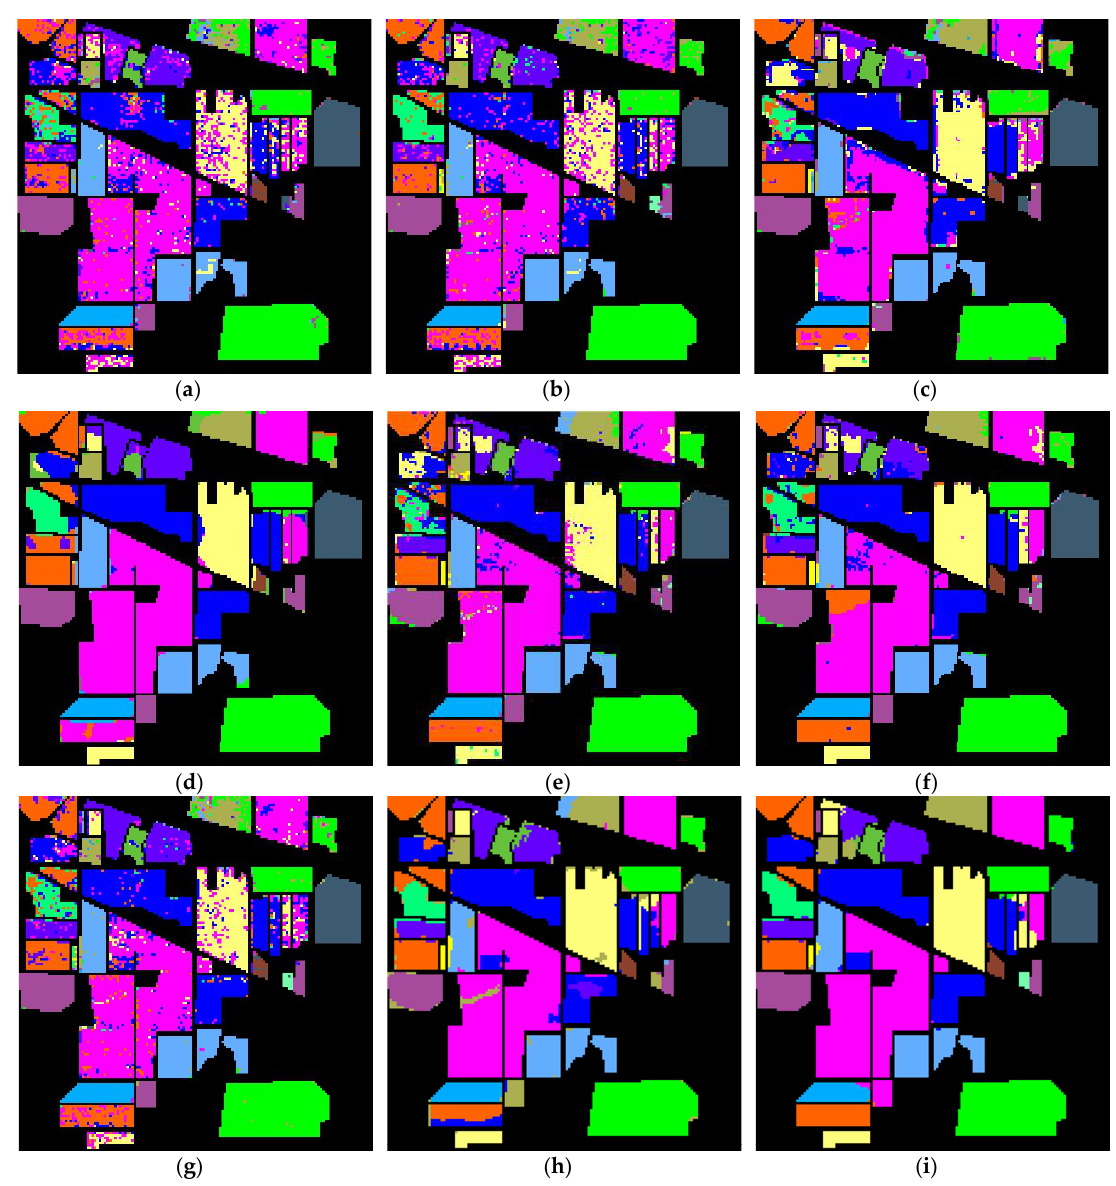
Figure 8. Indian Pines dataset using ( a ) SVM; ( b ) LRR; ( c ) SVMCK; ( d ) SMLR_SpTV; ( e ) SPCK; ( f ) SCMK; ( g ) KLRR; ( h ) Sp_MKL_SVM; and ( g ) Sp_MKL_LRR. Table 1. The classification results on Indian Pines dataset.